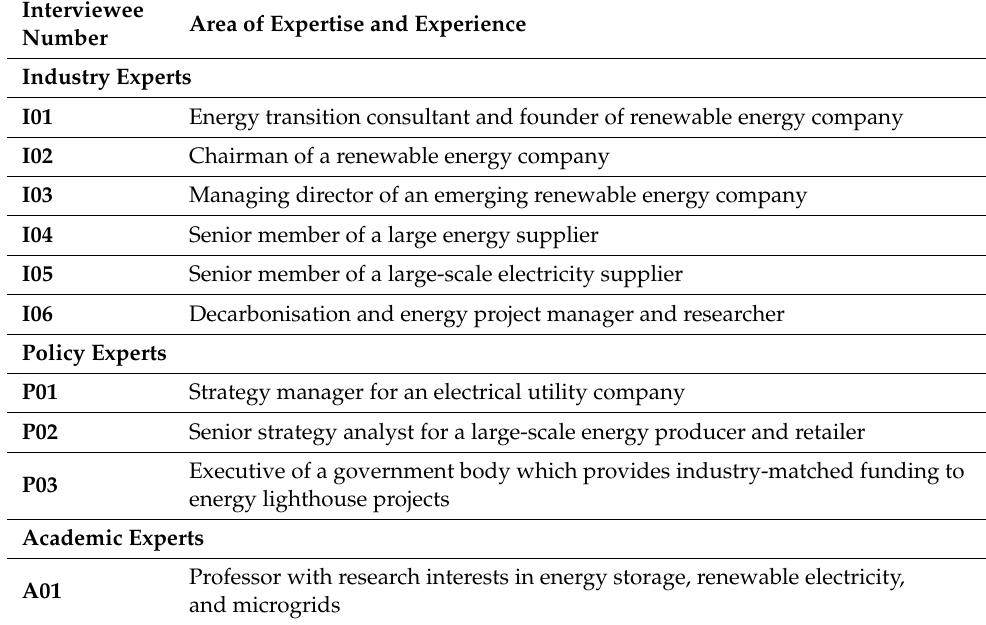
Table 2. Characteristics of the ten interviewees and their associated interviewee